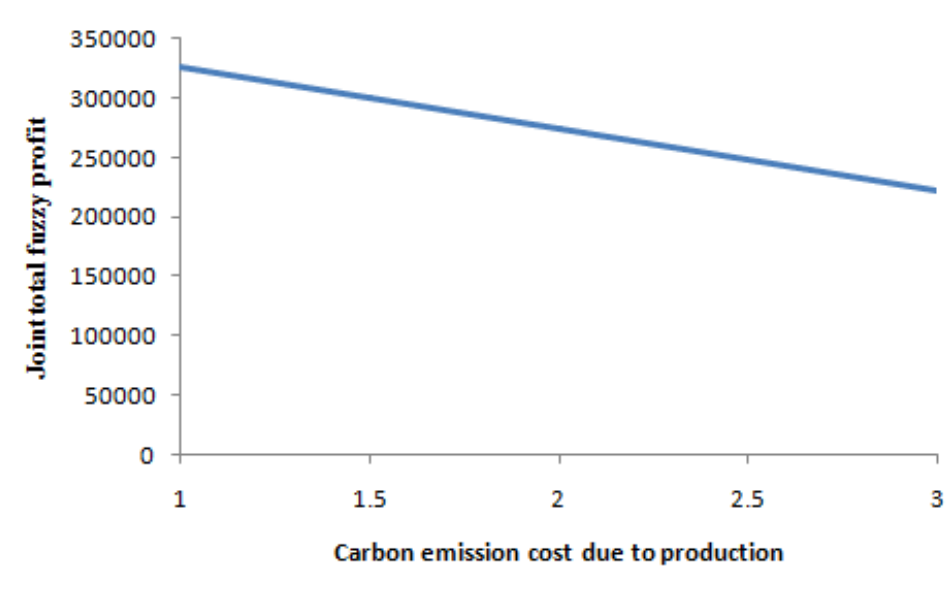
Figure 13. The carbon emission cost due to disposal vs. the total fuzzy profit.